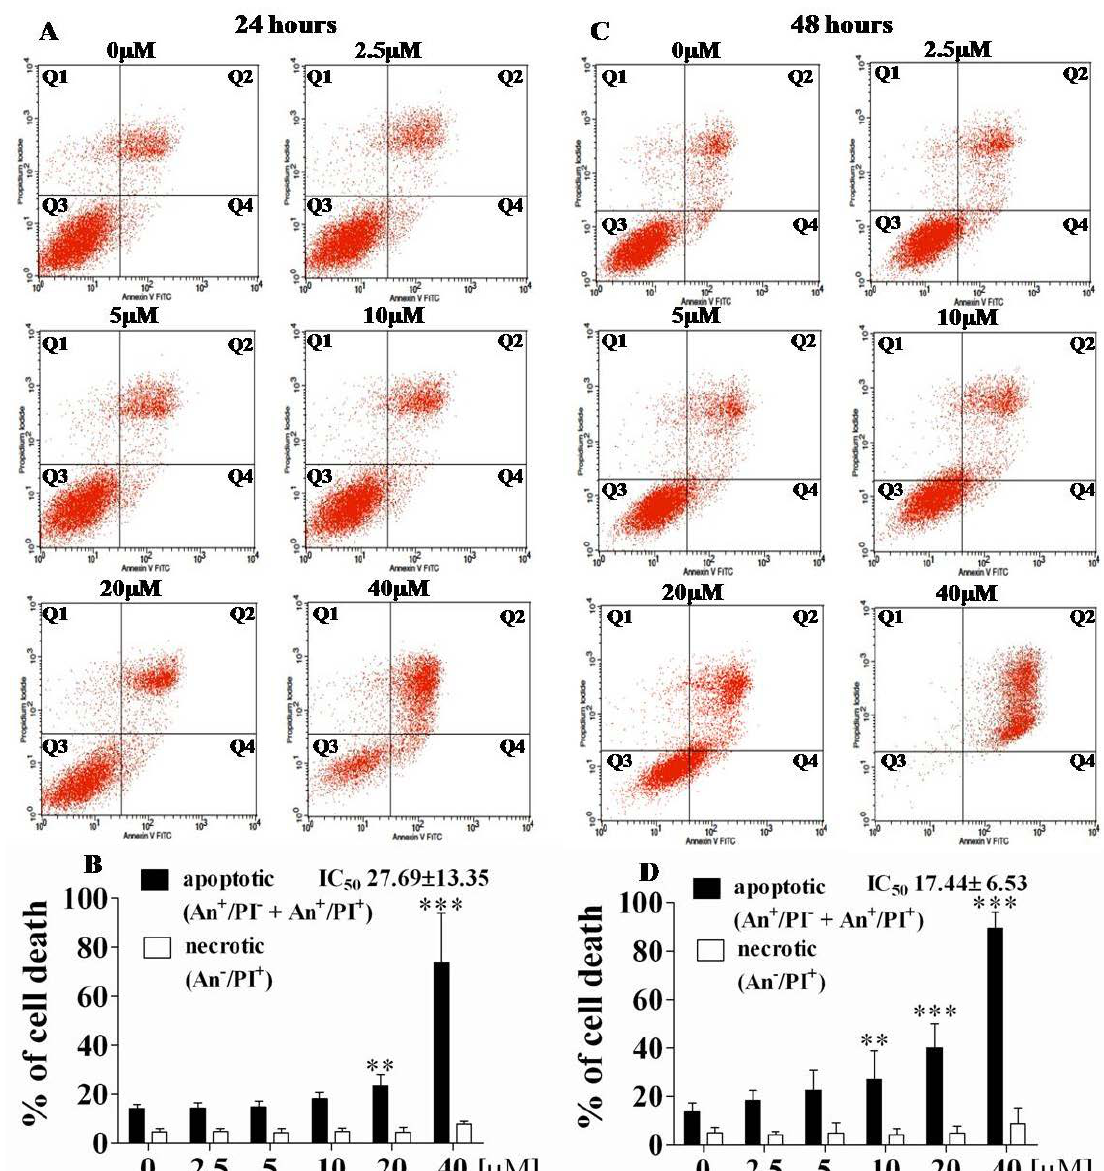
Figure 7. E ff ect of compound 3a on apoptosis / necrosis induction in the A549 cells. After the 24-h ( A ) and 48-h ( C ) exposure to the di ff erent concentrations of compound 3a , the cells were stained with Annexin (An) V-FITC / propidium iodide (PI) and examined with flow cytometry. Quadrant Q1 represents An − / PI + necrotic cells, Q2—An + / PI + late apoptotic cells, Q3—An − / PI − viable cells, Q4—An + / PI − early apoptotic cells. Histogram representation of the quantitative percentage of total apoptotic cells (early + late apoptosis) and necrotic cells in the control and compound 3a -treated cell cultures after the 24-h ( B ) and 48-h ( D ) treatment. All experiments were repeated independently at least three times, and data ( n = 6 for each concentration) are expressed as mean ± SD; ** p < 0.01 and *** p < 0.001 in comparison to the control; one-way ANOVA